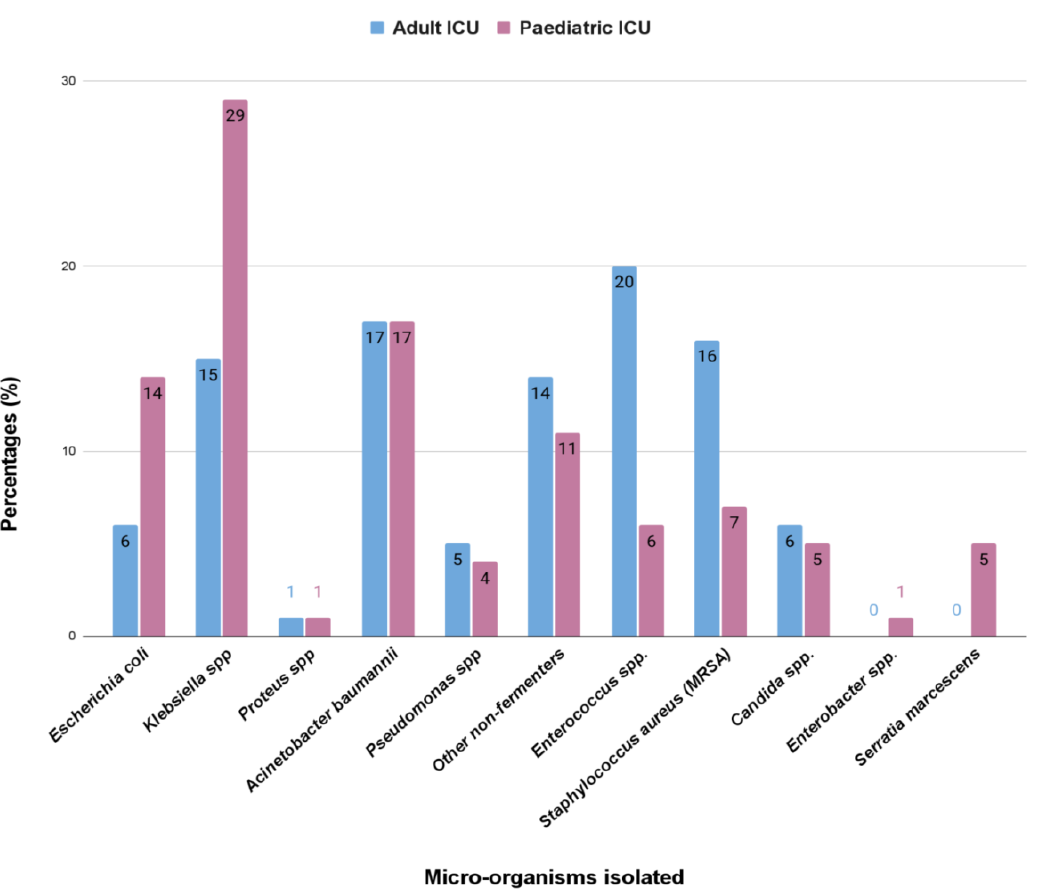
Figure 1. The comparison (in percentage, %) in the pattern of the microorganisms isolated from the bloodstream infections in the adult and pediatric intensive care unit.